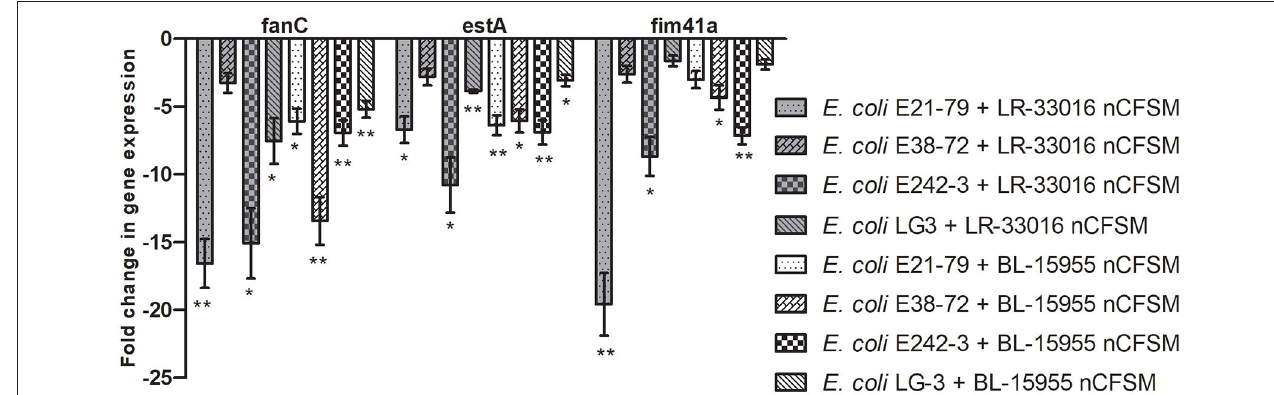
FIGURE 3 | Effect of L. reuteri LR-33016 and B. longum BL-15955 nCFSM on virulence gene expression of 4 E. coli F5 strains presented as fold change of expression levels in nCFSM relative to non-fermented milk. The expression data were normalized to two validated reference genes, gapA and nusG . Three independent replicates including two technical replicates each were performed. The data shown represents the mean and the error bars represent standard deviations. The stars indicate statistical significance at different levels: * P ≤ 0.05, ** P ≤ 0.01.